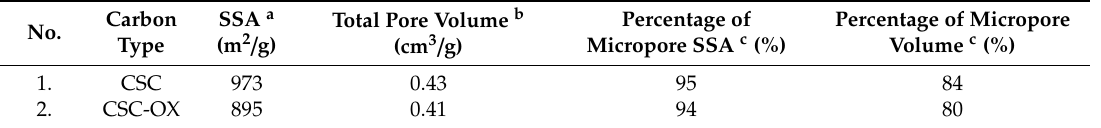
Table 1. Analysis result of surface area with the nitrogen sorption method.